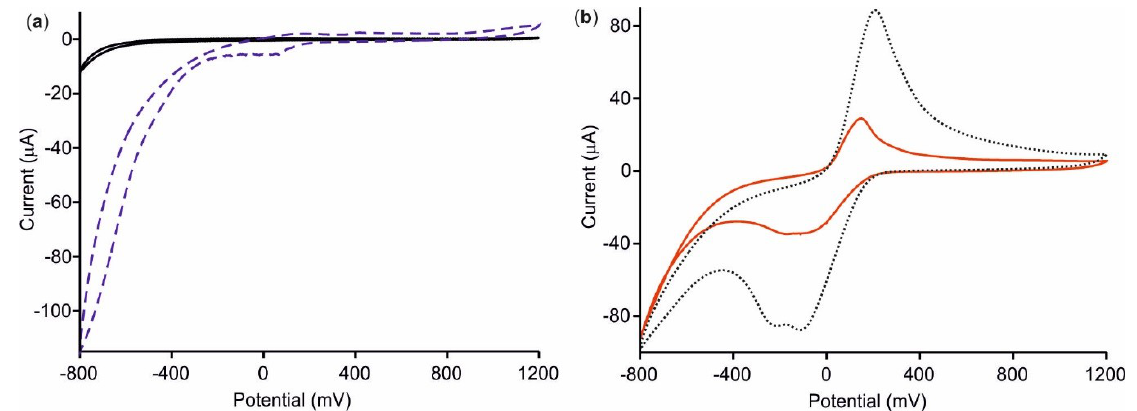
Figure 5. Cyclic voltammograms of ( a ) bare ITO (solid black line) and [CHI+IL/CuPc S ] 2 film (dashed blue line), and ( b ) ITO-GAO (solid red line) and [CHI+IL/CuPc S ] 2 -GAO (dotted black line), immersed in galactose 10 −4 mol·L −1 in 0.01 mol·L −1 phosphate buffer, pH 7. Scan rate 100 mV·s −1 .